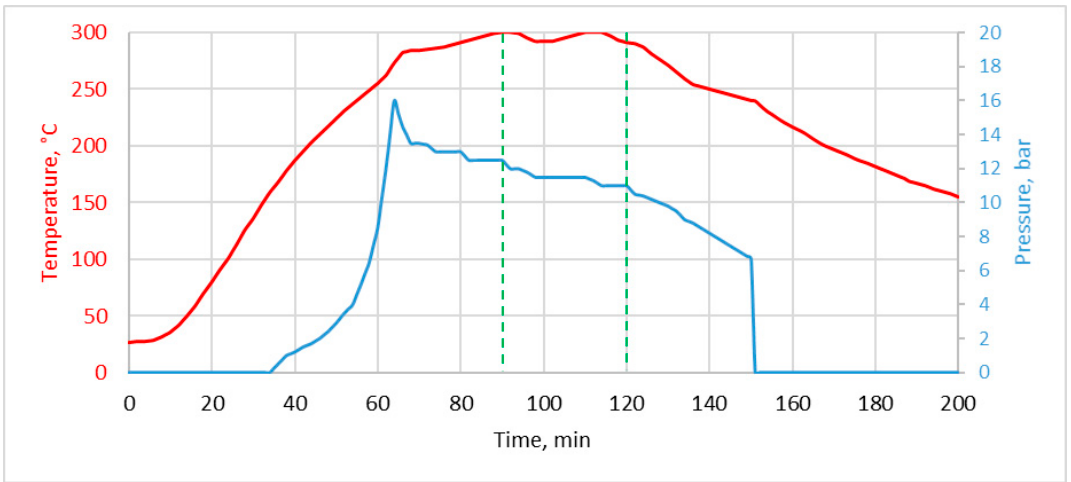
Figure 4. An example of temperature patterns during the atmospheric torrefaction (ap), green dashed line stands for start and end of the torrefaction process (30 min).